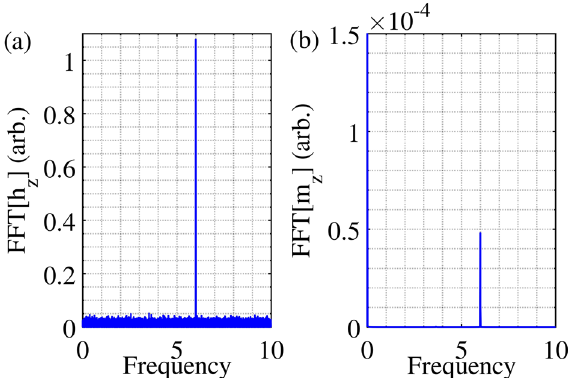
Figure 2. Selective property of parametric pumping. When a 6 GHz microwave signal is employed in the presence of phase-noise with zero mean and standard deviation of 80°, there occurs noise-rejection at frequencies other than 6 GHz in the absorption. ( a ), ( b ) represent the Fourier transform of the microwave input signal and the longitudinal component of magnetization ( m z ) respectively. A microwave field of 7.5 Oe is